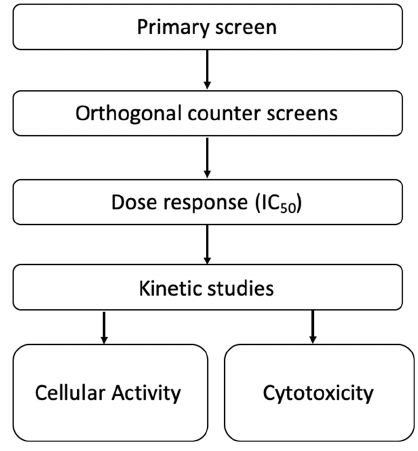
Figure 3. Compound screening pipeline.